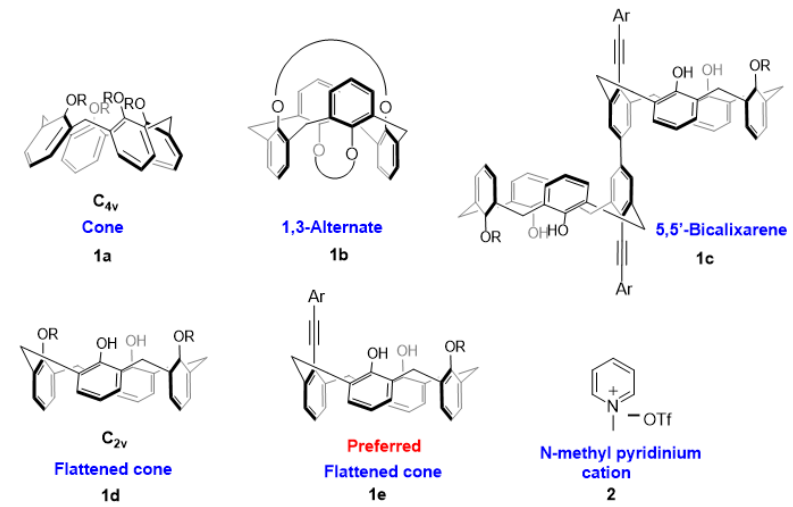
Figure 1. Representative calixarene scaffolds for host–guest chemistry.